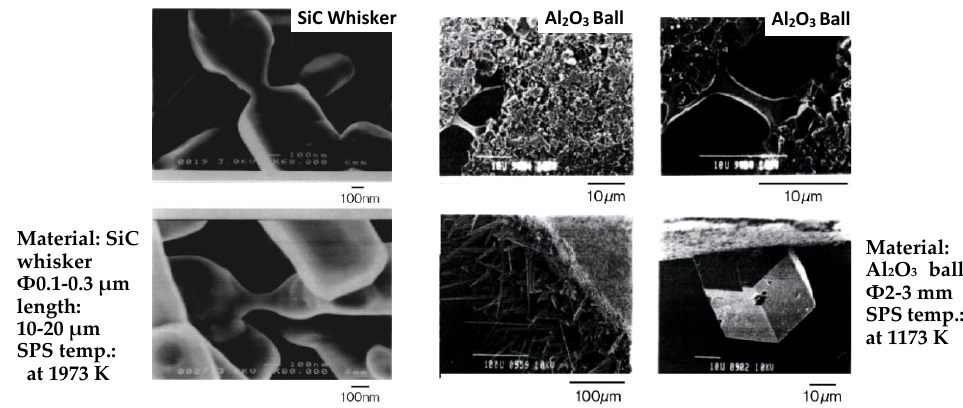
Figure 13. Collateral evidence examples of SPS effects on ceramic materials [34,36]. 3.5. DC Pulse Generator for SPS System